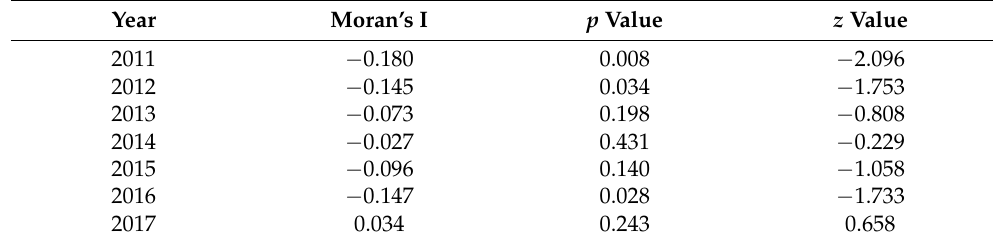
Table 2. Moran’s I statistical values for the EWP in the Yellow River Basin between 2011 and 2017. Year Moran’s I p